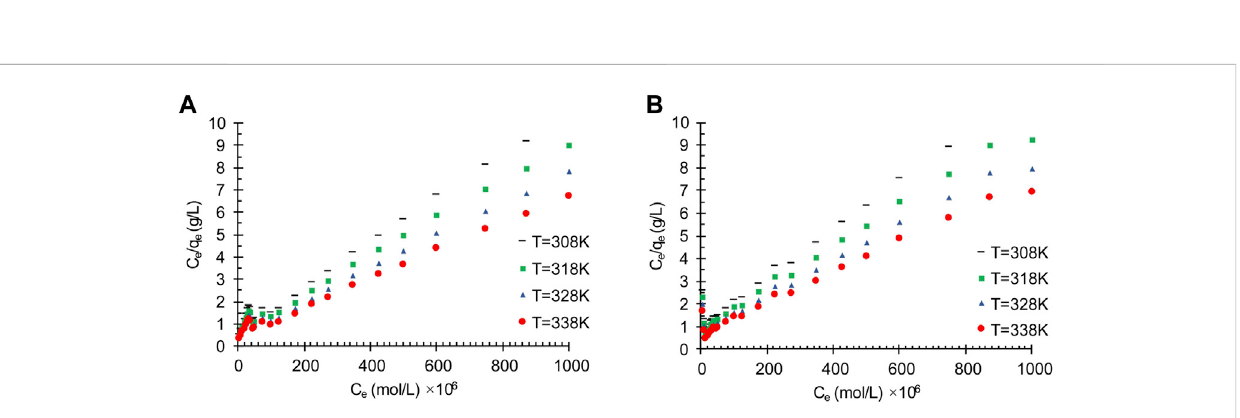
Frontiers in Environmental